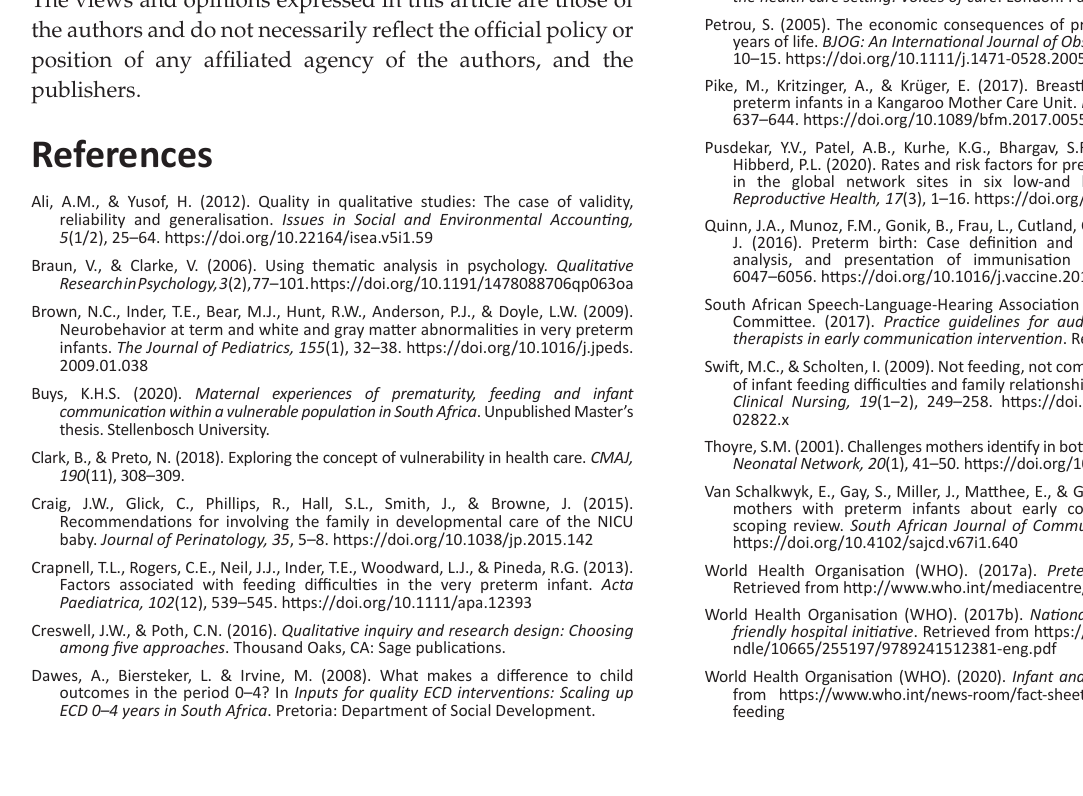
Appendix starts on the next page